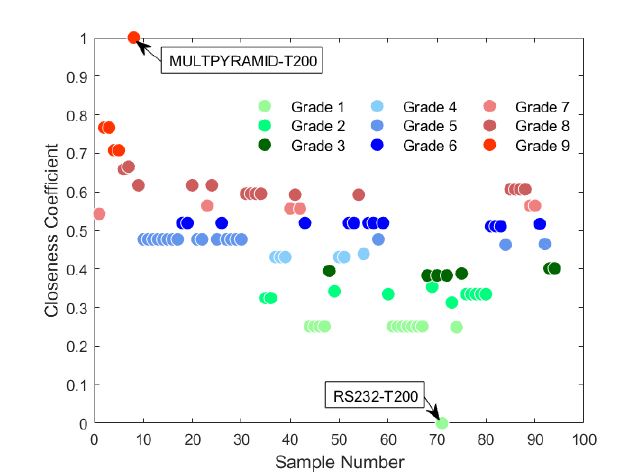
Figure 1. Threat-grading results for the 94 HTs found on Trust-hub.